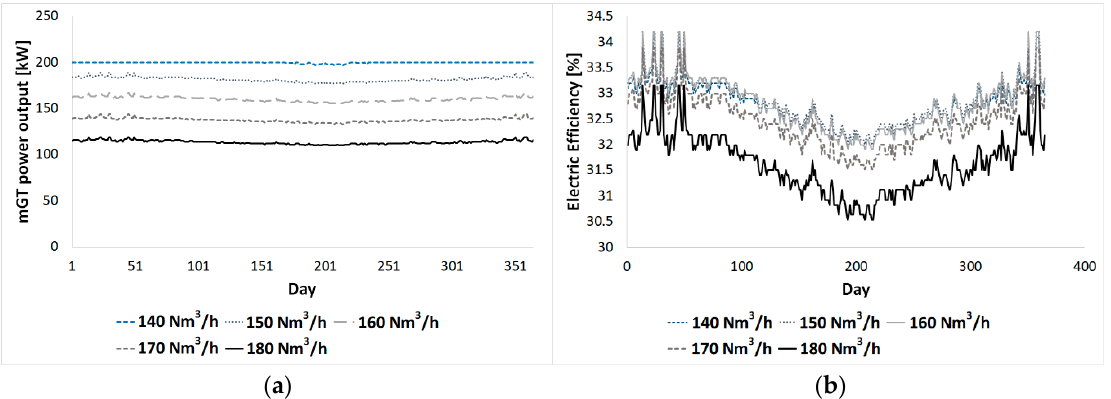
Figure 15 . The micro-gas turbine (mGT) power output ( a ) and electric efficiency ( b ) for various sizes of upgrading unit.